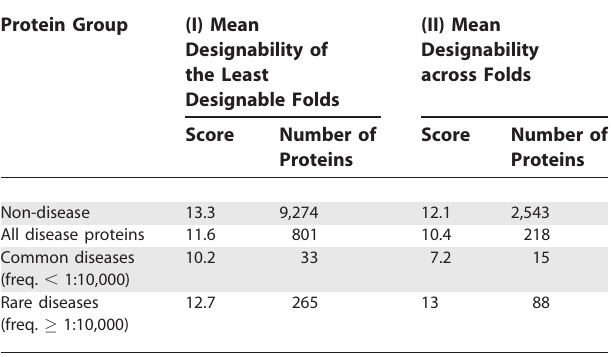
Table 1. Designability and Disease Frequency Protein Group (I) Mean Designability of the Least Designable